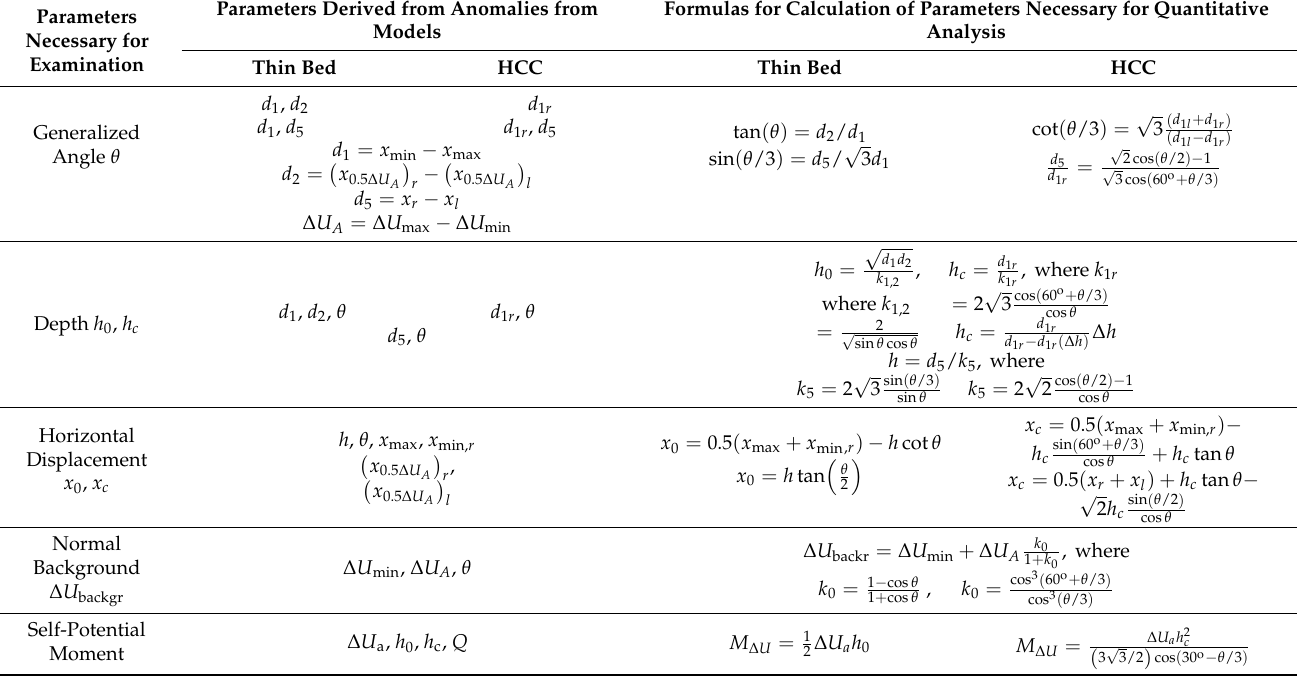
Table 3. Formulas for quantitative interpretation of magnetic anomalies from bodies approximated by thin bed (TB) and horizontal circular cylinder (HCC) using the improved characteristic point method (after [40], with modifications).